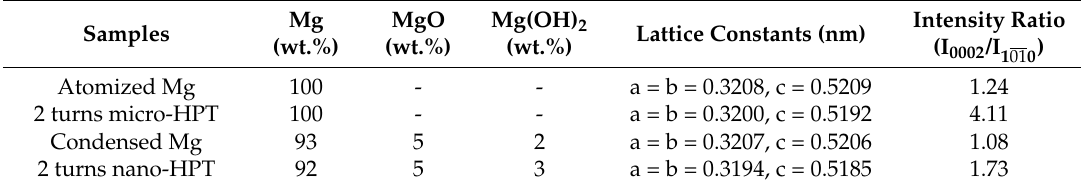
Figure 2. Normalized X-ray diffraction (XRD) patterns recorded on the initial powder precursors and their high-pressure torsion (HPT) products: ( a ) atomized Mg powder and its micro-HPT product; ( b ) condensed Mg powder and its nano-HPT product. Table 1. Phase composition and crystallographic data for the two types of HPT products obtained from the XRD profile refinement using the JADE software